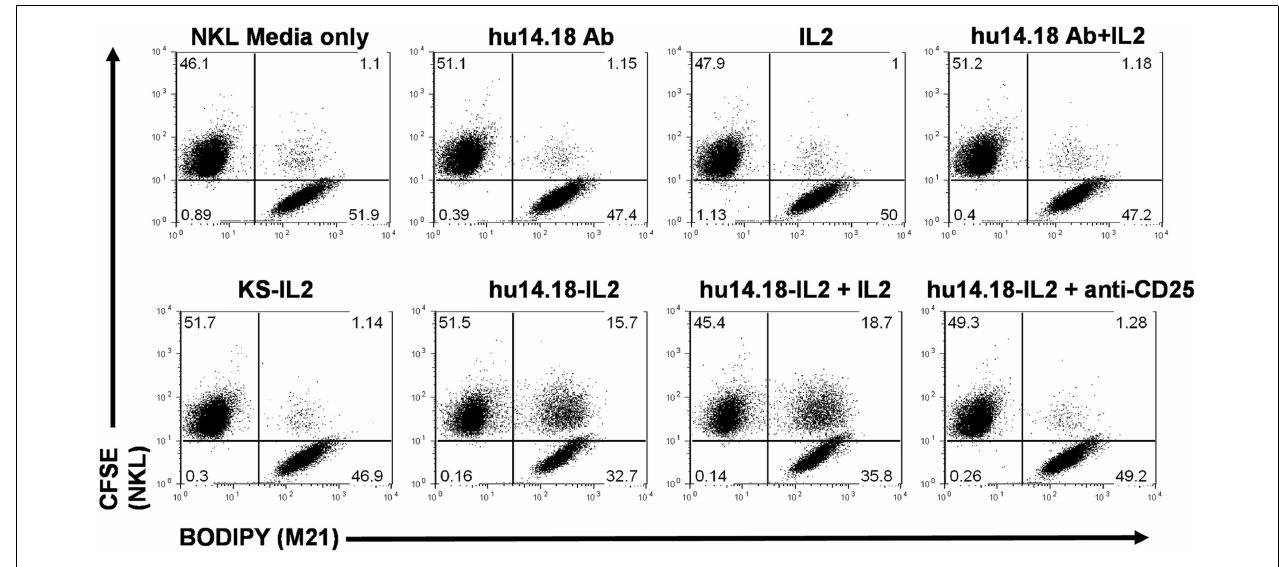
FIGURE 1 | 14.18-IL2 IC increases conjugate formation between M21 (GD 2 + tumor cells) and NKL cells, and conjugate formation can be blocked with an anti-CD25 (IL2R α -chain) mAb in flow cytometry conjugate assays. M21 and NKL cells were dyed with BODIPY and CFSE respectively, incubated together with the depicted treatments and analyzed for conjugate formation. huKS-IL2 IC, which recognizes EpCAM not GD 2 , was